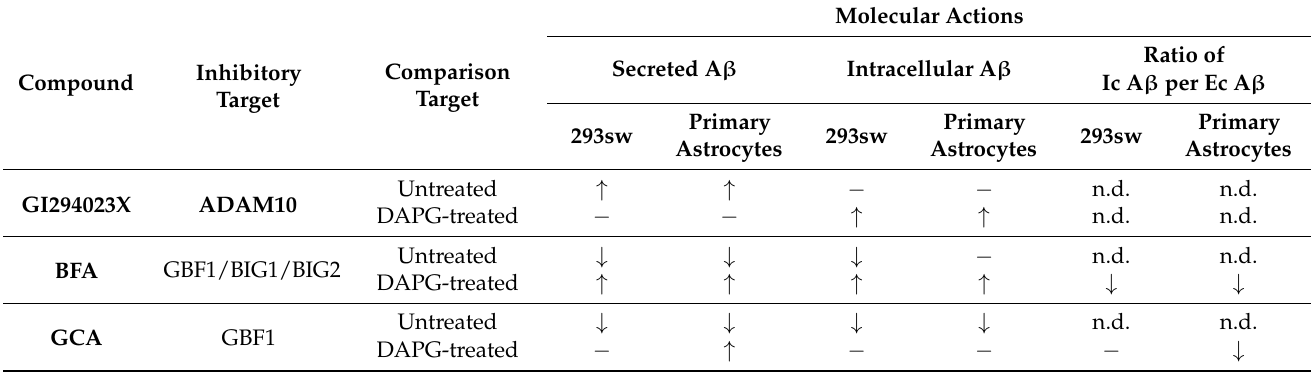
Table 2. Summary of changes in A β parameters by GI293023X, BFA, or GCA alone and co-treatment with DAPG. Changes are shown compared to untreated cells (untreated) and DAPG-treated cells (DAPG-treated), respectively (Ic, intracellular; Ec, extracellular; n.d., not